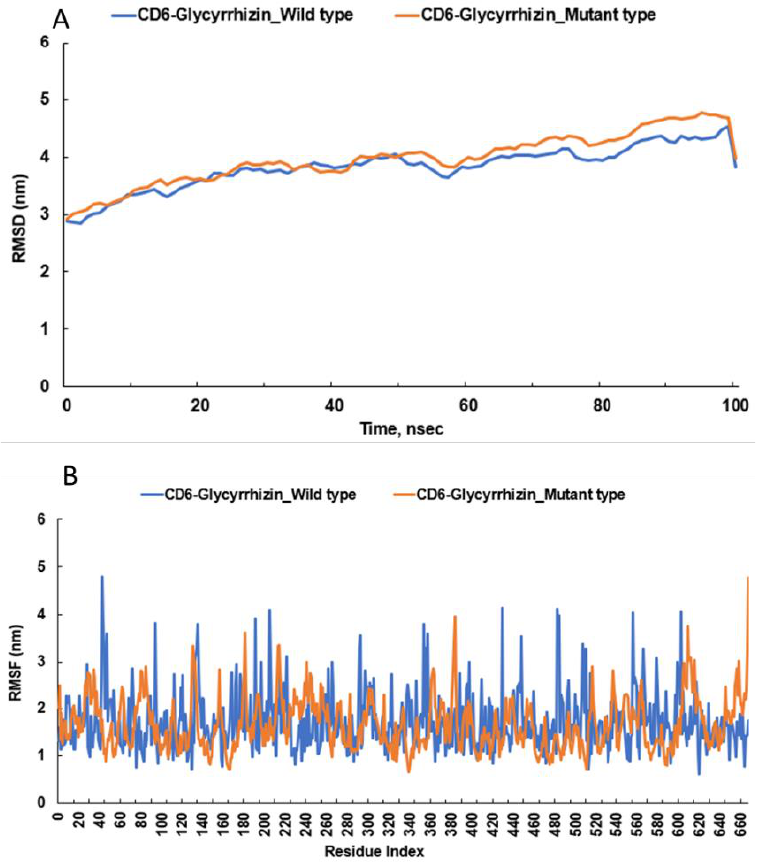
Figure 5. Molecular dynamic simulations between the active site of wild and mutated CD6 protein and glycyrrhizin ( A ) The root mean square deviation (RMSD) of glycyrrhizin binding to the wild and mutated types of CD6. ( B ) The root mean square fluctuations (RMSF) of glycyrrhizin binding to the wild and mutated types of CD6.